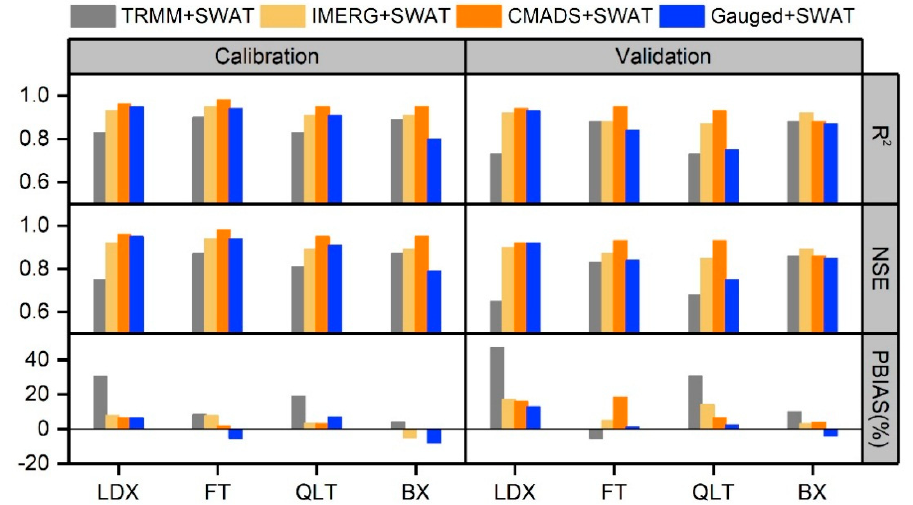
Figure 6. The Performance metrics (R 2 , NSE, and PBIAS) of the four modes of monthly streamflow simulations.